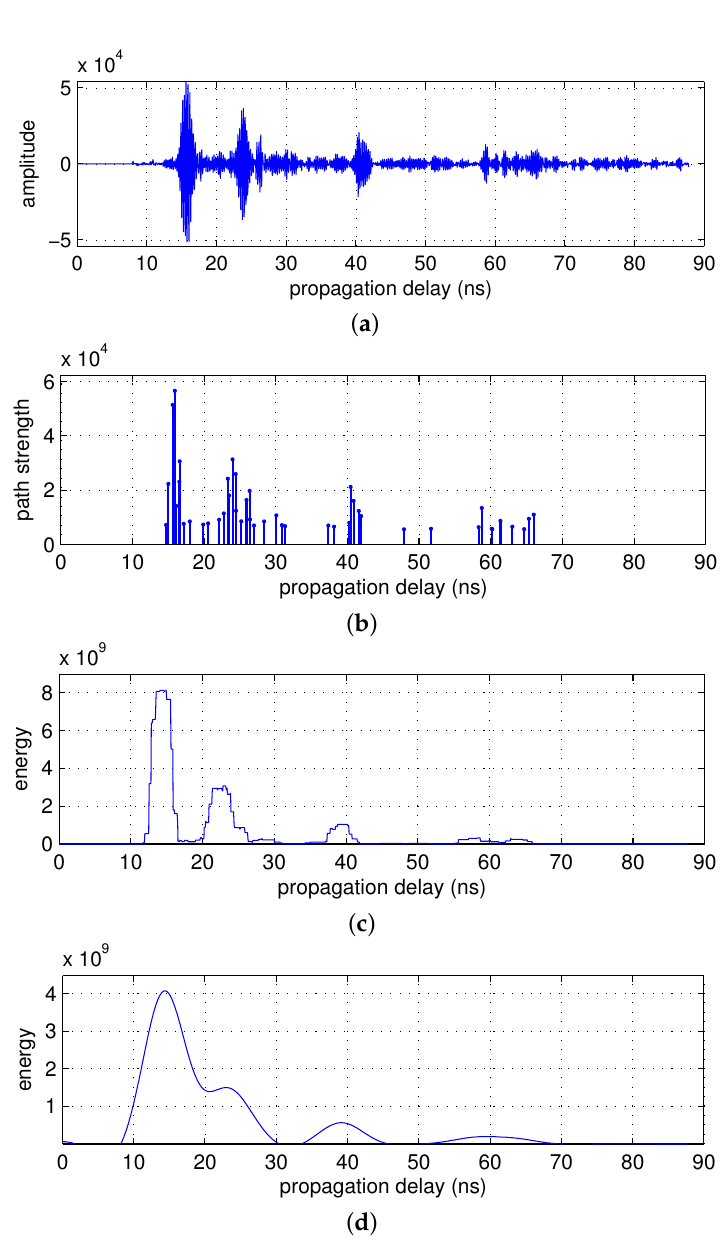
Figure 3. Deconvolution and cluster identification for the 170th scan of measurement set 7. ( a ) z ( τ ; t ) ; ( b ) magnitude of the impulse response; ( c ) output of a sliding correlator; and ( d ) output of a low-pass